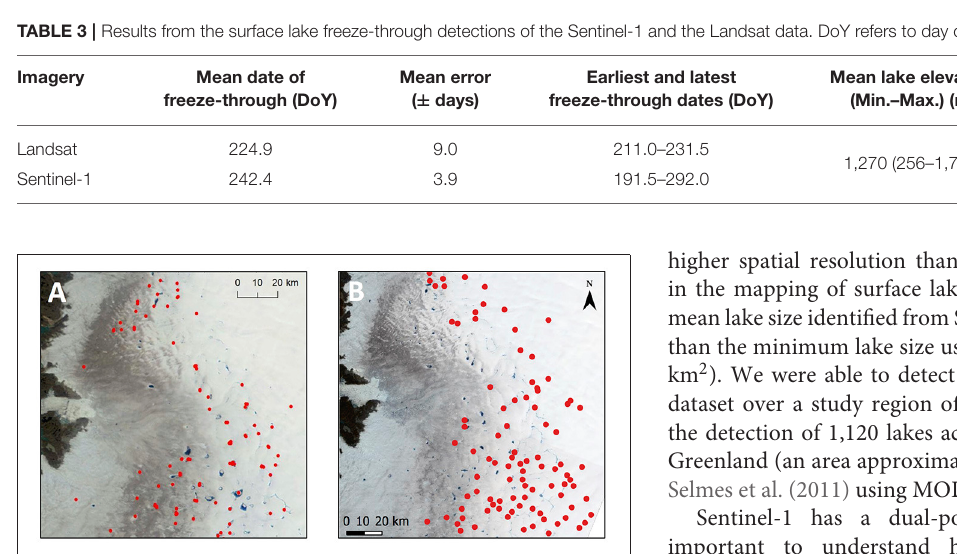
FIGURE 9 | Comparison of the buried lake distribution mapped by Koenig et al. (2015, their Figure 3) using IceBridge Ice Sounding Radar (A) , to a subset of the subsurface lakes mapped in the current study covering the same extent as the Koenig et al. (2015) study (B) (location within the study region shown in Figure 1 ). Koenig et al.’s (2015) diagram background is a MODIS image from August 2010; ours is a Landsat false-color image from day 212 (31 July) in 2015. Figure adapted from Koenig et al. (2015), available under a Creative Commons Attribution 3.0 License.